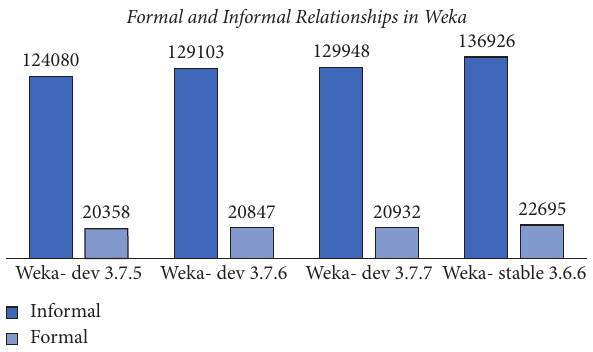
Figure 20: Count of formal and informal relationships in weka.